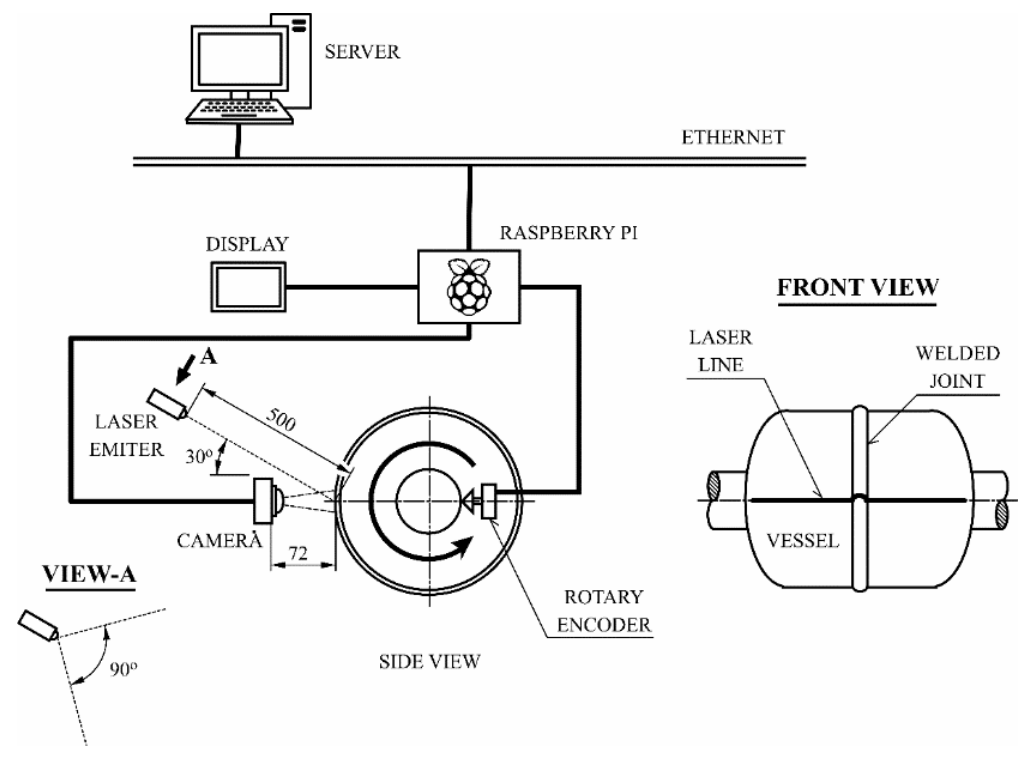
Figure 1. System overview.